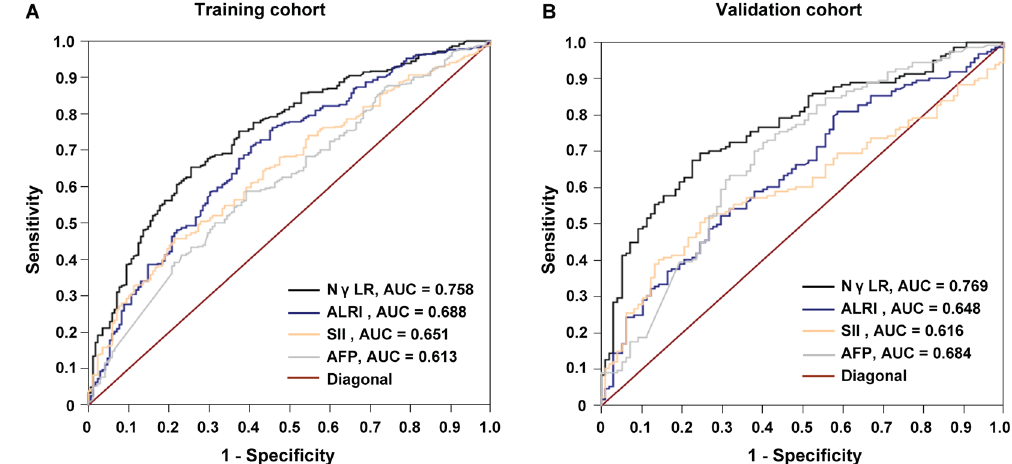
Figure 2. Predictive ability of the N γ LR and the correlation between N γ LR and AFP. The predictive ability of N γ LR was compared with other prognostic parameters by ROC curves in the training ( A ) and the validation ( B )